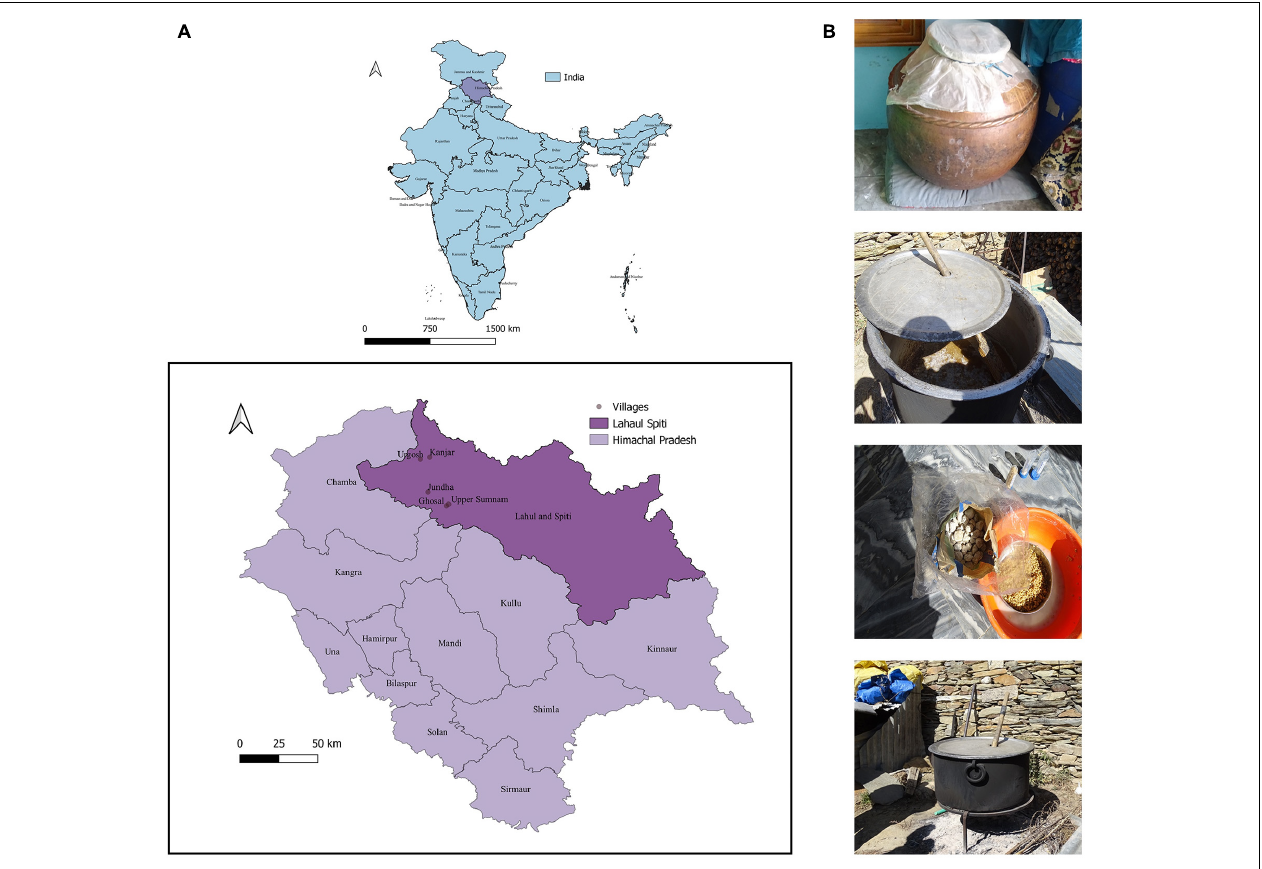
FIGURE 1 | Sampling site location and various undistilled lugri samples. (A) Illustration of the map depicting the geographical location of the Lahaul and Spiti district of Himachal Pradesh. The sites include the tribal villages of the Lahaul valley namely: Ghosal (32.54911 ◦ N–76.96941 ◦ E), Jundha (32.64105 ◦ N–76.84492 ◦ E), Kanjar (32.87251 ◦ N–76.85702 ◦ E), Upper Sumnam (32.55920 ◦ N–76.98329 ◦ E), and Urgosh (32.85852 ◦ N–76.79588 ◦ E), and samples were collected in sterile sample containers. The map was made in QGIS version 3.10.5 (URL: http://qgis.org). The villages from where the sample was collected are shown after zooming out. (B) The traditional method of preparation of lugri , the figure shows vessel and starter culture “ phab ” used to prepare lugri